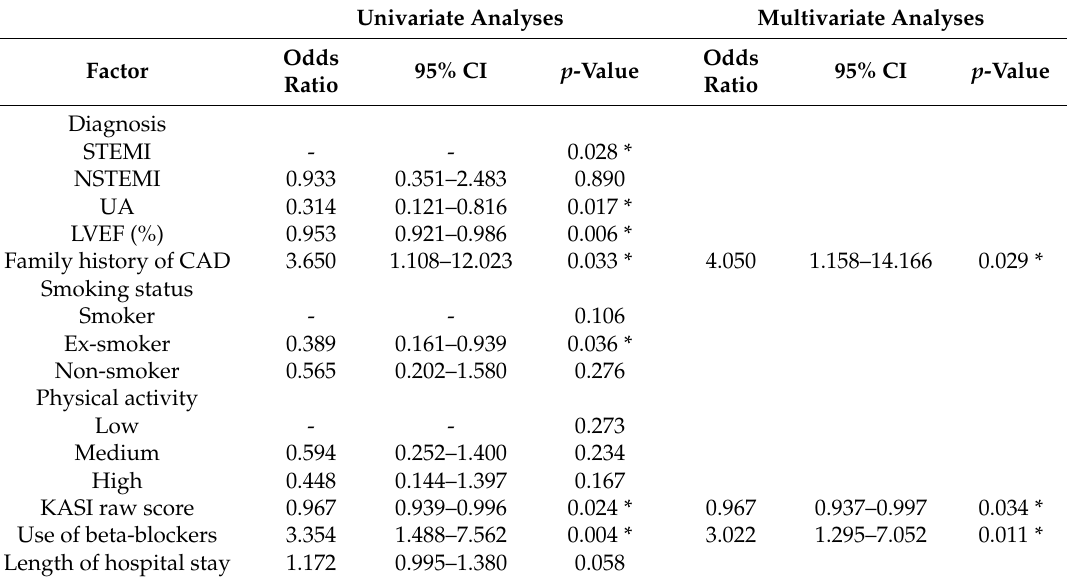
Table 4. Causational factors for depressive mood in patients with CAD. Univariate Analyses Multivariate Analyses